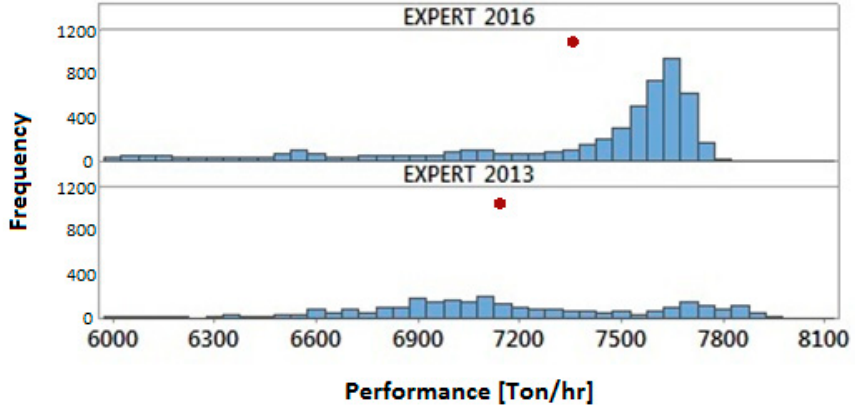
Figure 6. Frequency of data between expert systems.